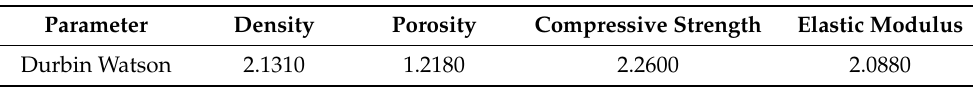
Table 17. Durbin Watson coefficient of multiple linear regression analysis (excluding abnormal